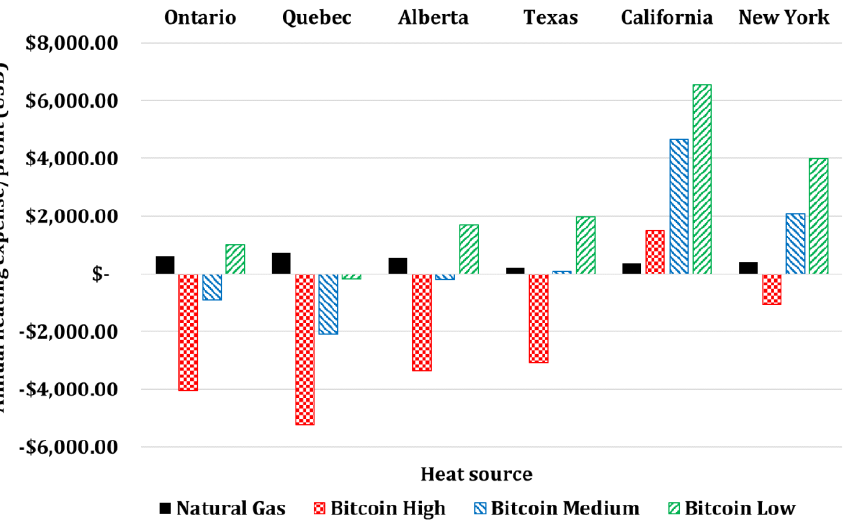
Figure 34. Annual heating expense/profit with natural gas and Bitcoin mining (after considering Bitcoin selling price) sources in six North American locations to heat Greenhouse 1.